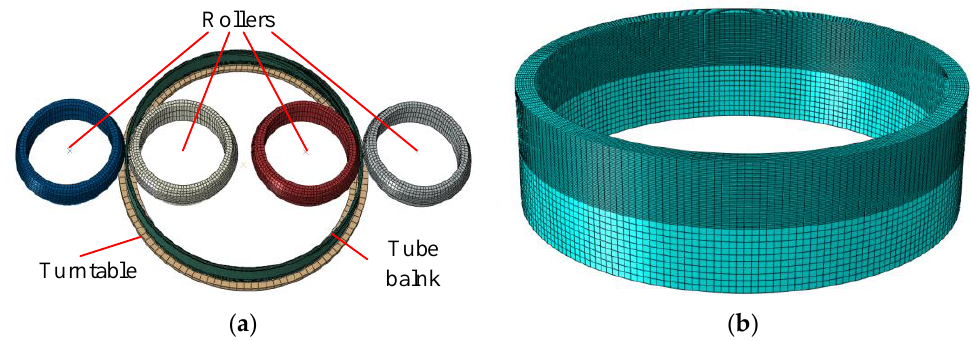
Figure 3. The numerical simulation model for the CRFF process: ( a ) Total model; ( b ) The mesh model of 720 mm diameter tube blank. of 720 mm diameter tube